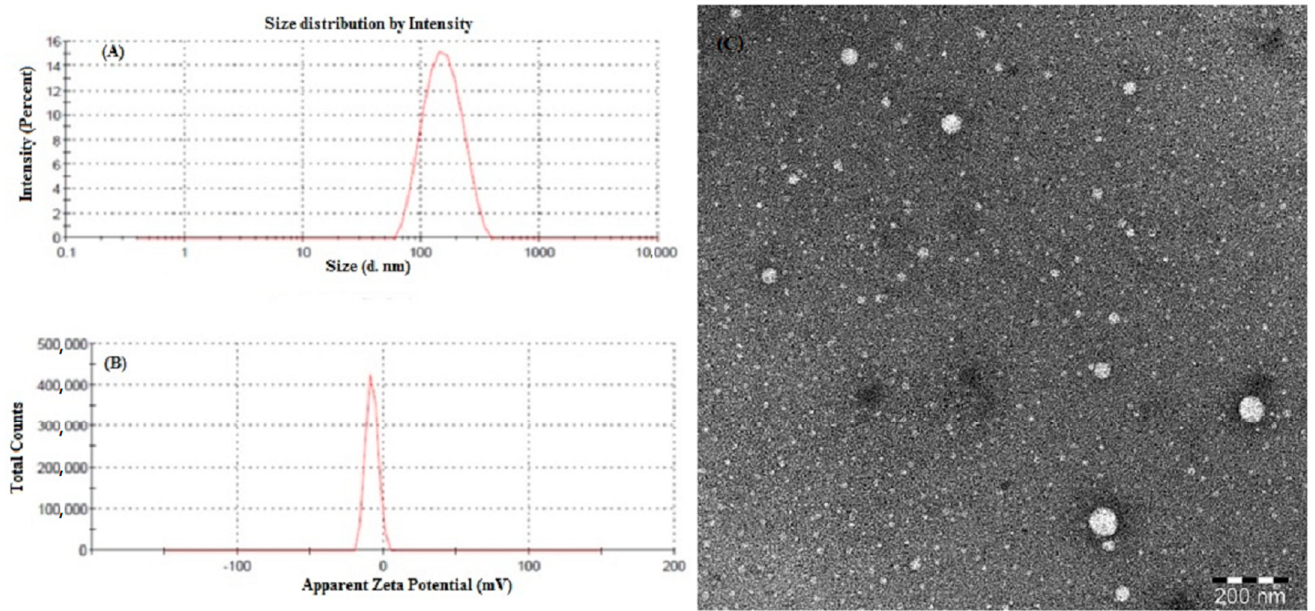
Figure 3. Characterization of optimized ETO-NE formulation (F2): Distribution of droplet size ( A ), and zeta potential ( B ). Droplet morphology of F2 formulation observed in Transmission Electron Microscopy ( C